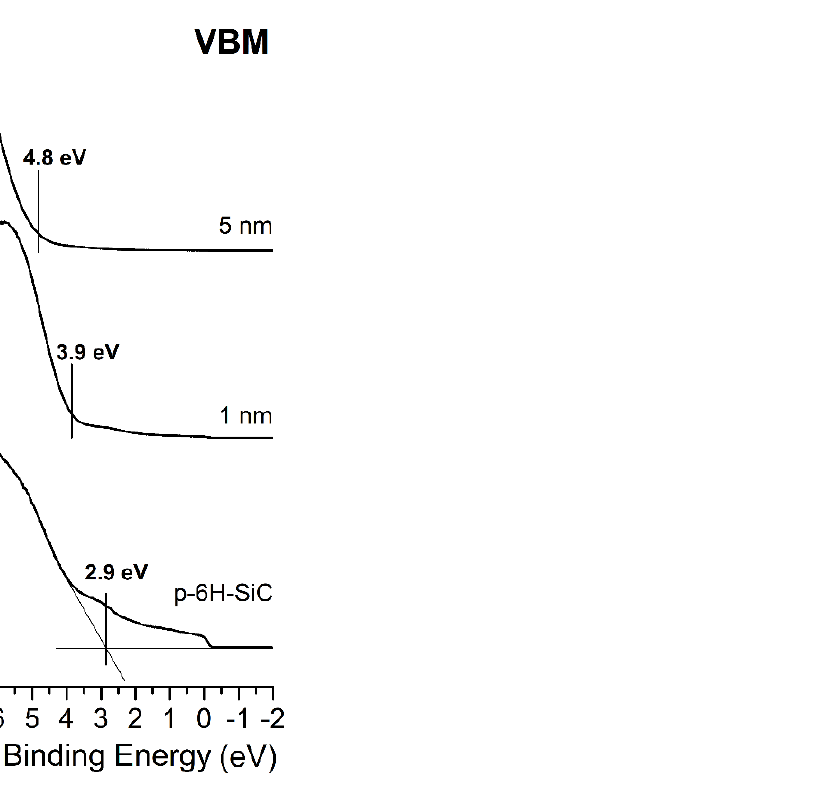
Figure 7. Evolution of UPS spectra for the bare graphite/SiC system and covered with MgO layers of an average thickness of 1 and 5 nm. In the vicinity of the E F, the density of electron states from the graphite phase is clearly visible.